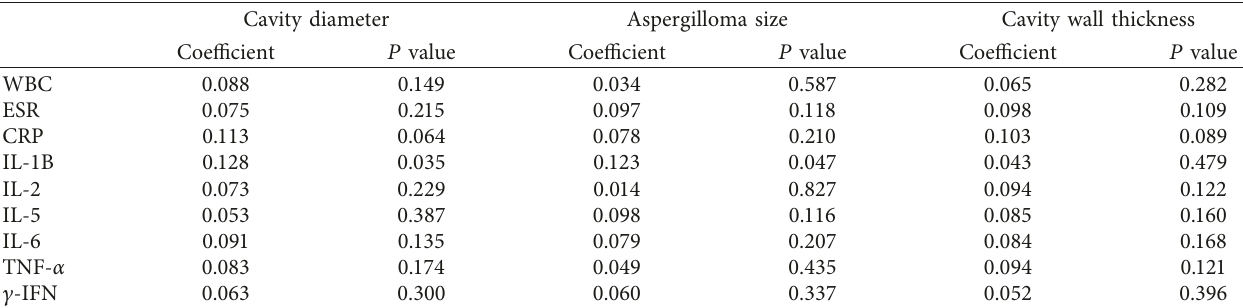
Table 3: Correlation of serum inflammatory factors with the activity of chronic pulmonary aspergillosis in the whole subjects. Cavity